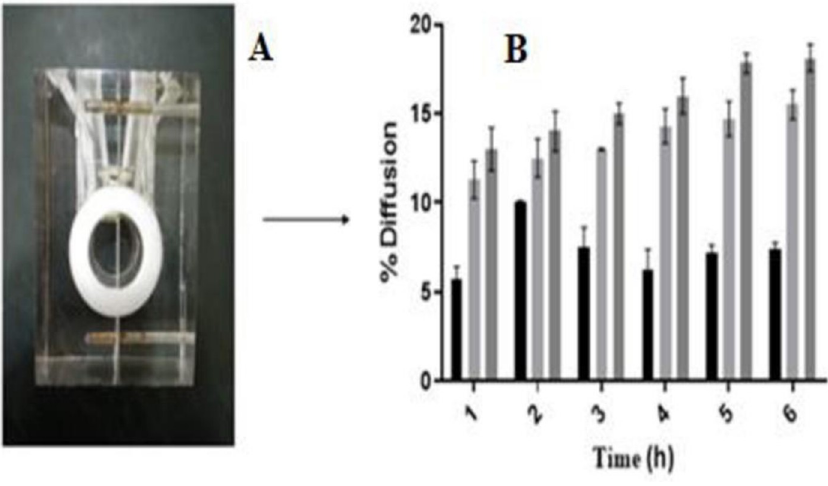
Fig 6. Drug diffusion study of CUR-3 ( & ), PEG-CUR3 ( ) PEG-CUR-C6 ( ) ointment formulations via ussing cell (A) at 37˚C. Graph in (B) showed increase in percentage permeability of PEG-CUR-C6 as compared to the Cur and PEG-CUR ointments across corneal membrane. Data is shown as mean ± SD (n = 3).